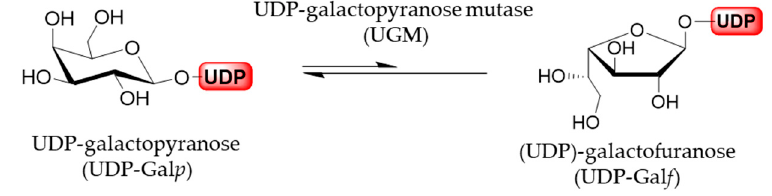
Figure 6. UGM-catalyzed izomerization of UDP-Gal p and UDP-Gal f .